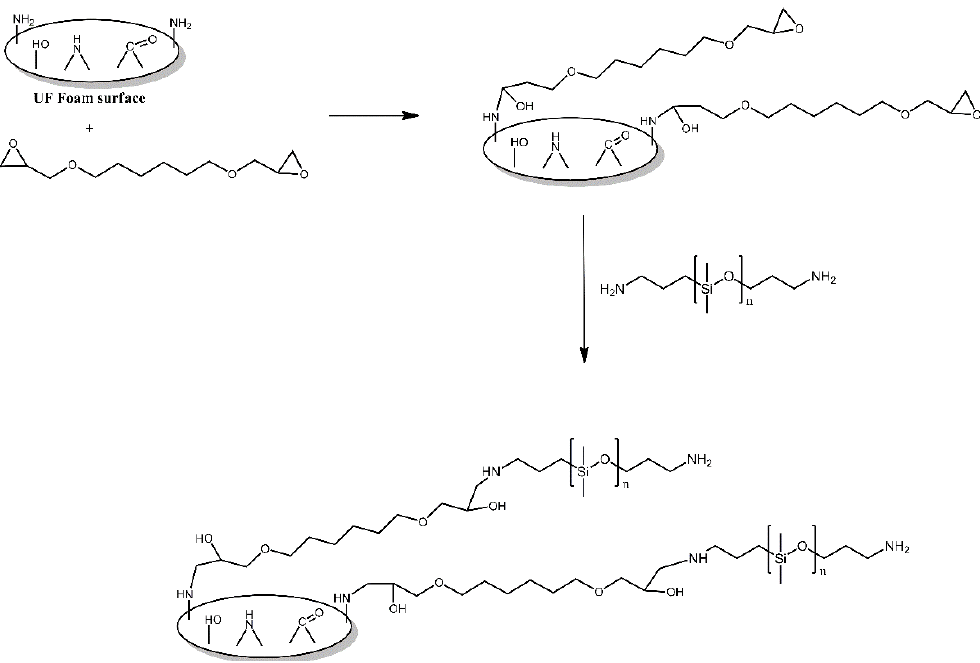
Figure 2. Schematic illustration of urea-formaldehyde foam surface grafted with aminopropyl-terminated PDMS via the bridging effect of 1, 6-hexanediol diglycidyl ether. Based on Ref. [5].